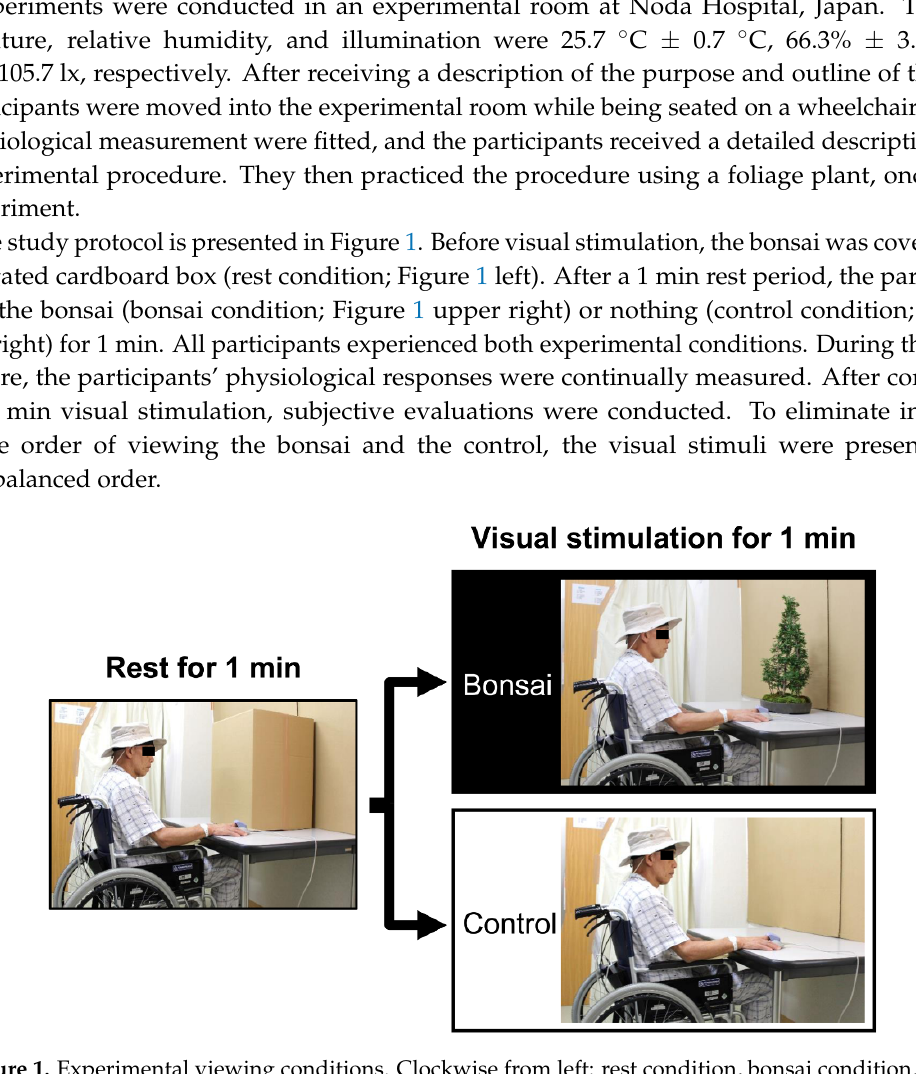
Figure 1. Experimental viewing conditions. Clockwise from left: rest condition, bonsai condition, and control condition.